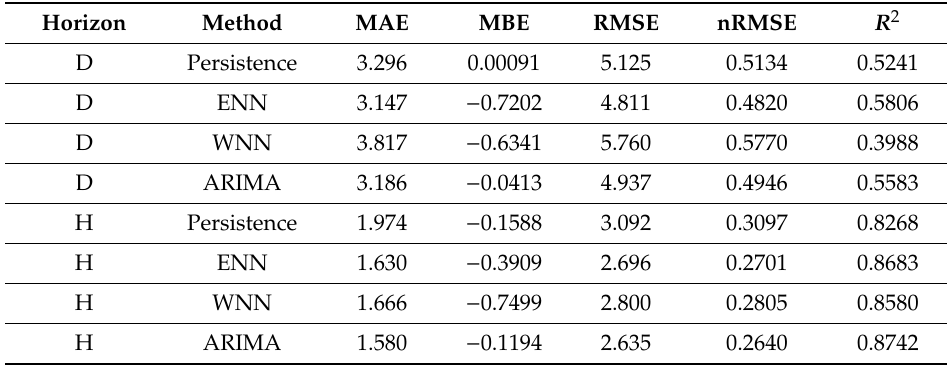
Table 5. The Errors Between the Forecasted and Actual Power Generation of the HPP.